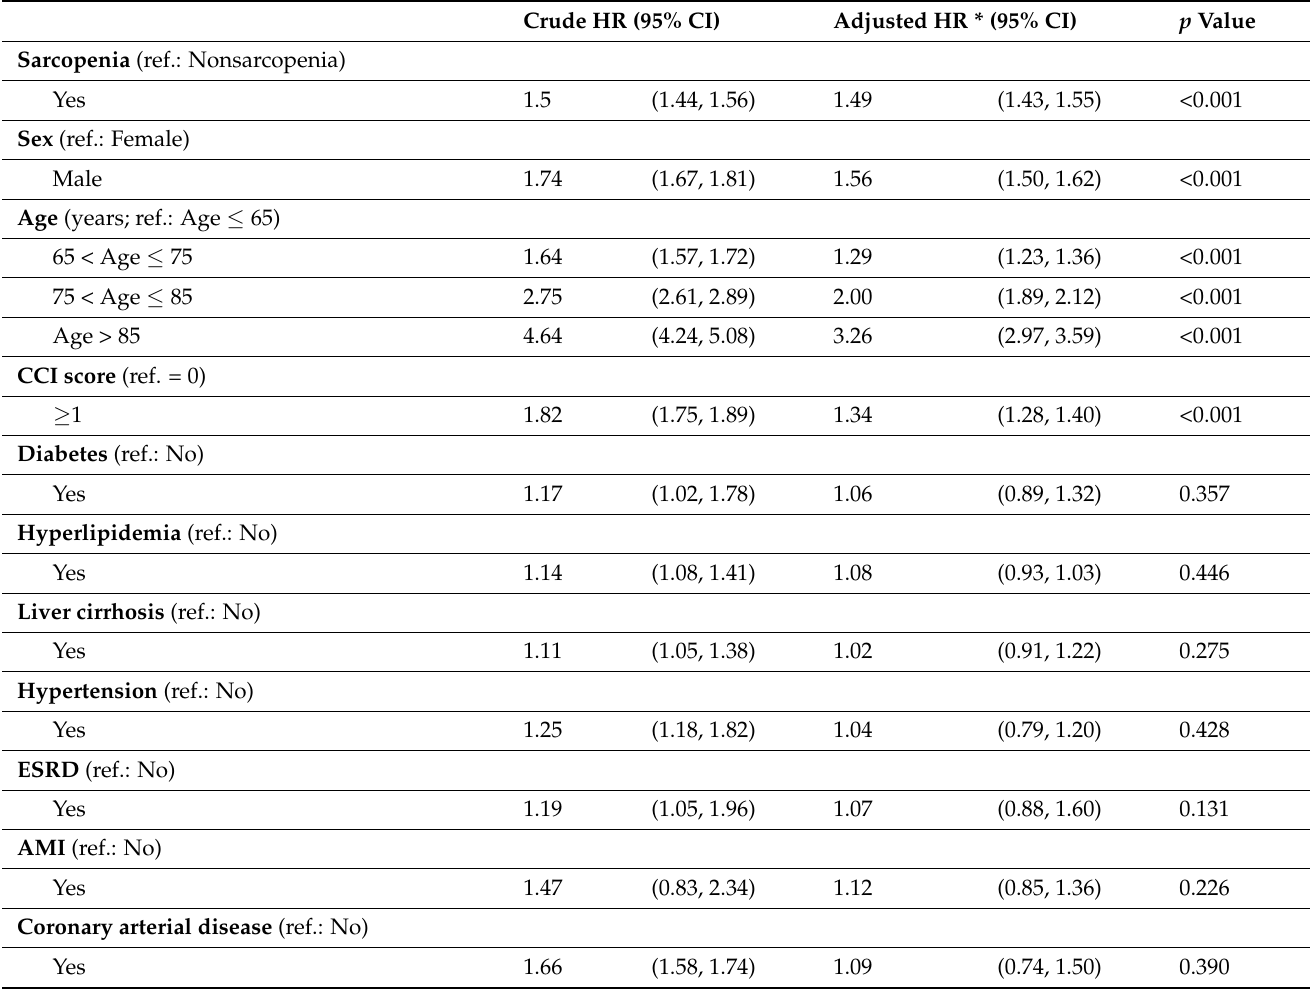
Table 2. Univariable and multivariable Cox proportional regression model for all-cause death of the propensity score–matched sarcopenia and nonsarcopenia